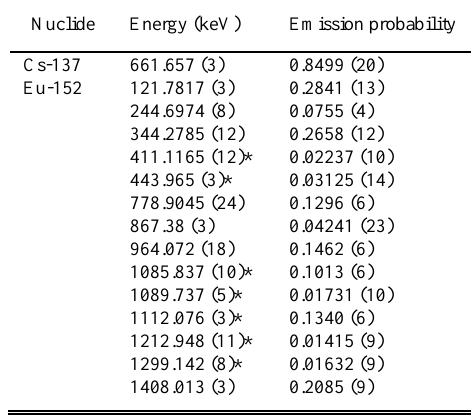
resolution response. Acquisition time of about 19h and 25h respectively.